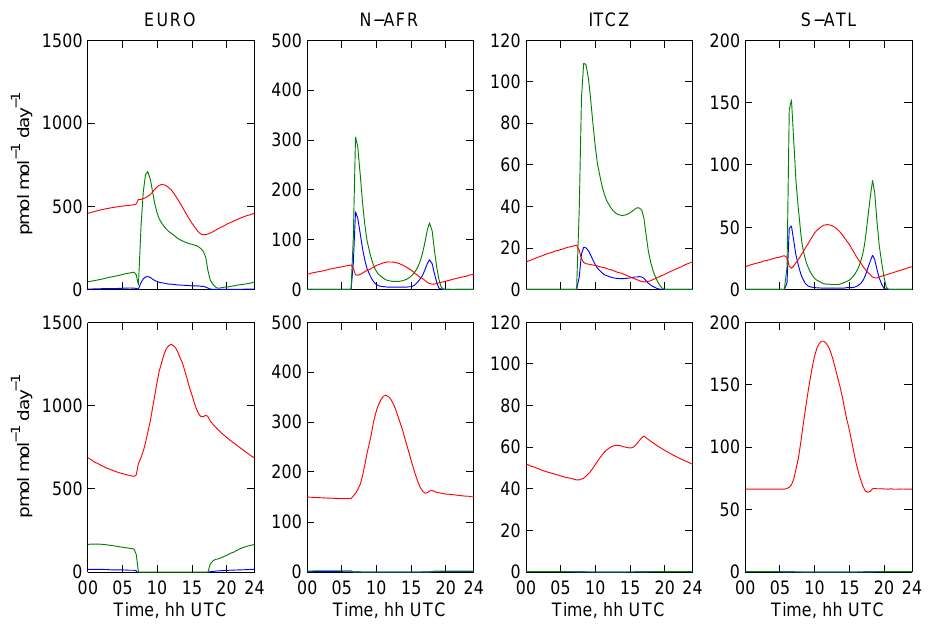
Figure 10. Fig. 10. Simulated diel cycles in selected NO x sinks for the four flow regimes. Values for runs “with halogens” are depicted in the top row of panels and those for “no halogens” are in the bottom row. Gas-phase sinks are in red, heterogeneous reactions involving sea salt are in blue, and those involving S aerosol are in green. Gas-phase reactions include NO 2 +O 3 , NO 2 +OH, and NO 3 +(CH 3 ) 2 S; HNO 3 photolysis is evaluated as a negative sink. Heterogeneous pathways include hydrolysis and reactions with particulate Cl − and Br − involving ClNO 3 , BrNO 3 , and N 2 O 5